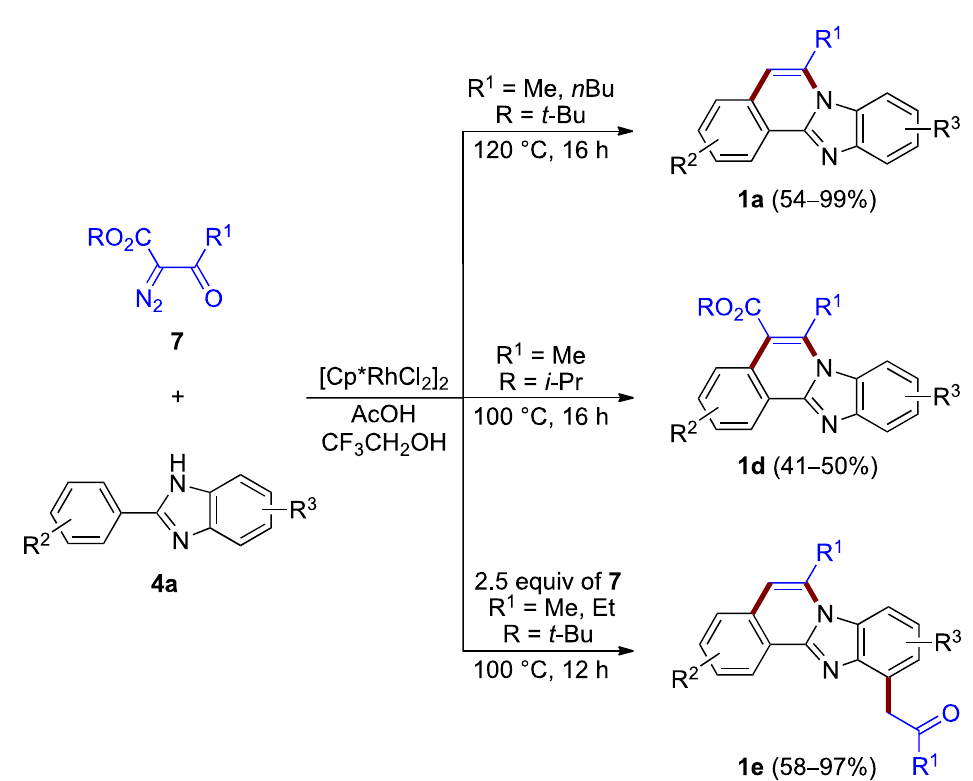
Figure 6. Synthesis of functionalized benzimidazo[2,1- a ]isoquinolines 1a , d , e via rhodium(III)-catalyzed annulation of α -diazoketoesters 7 and 2-arylbenzimidazoles 4a .